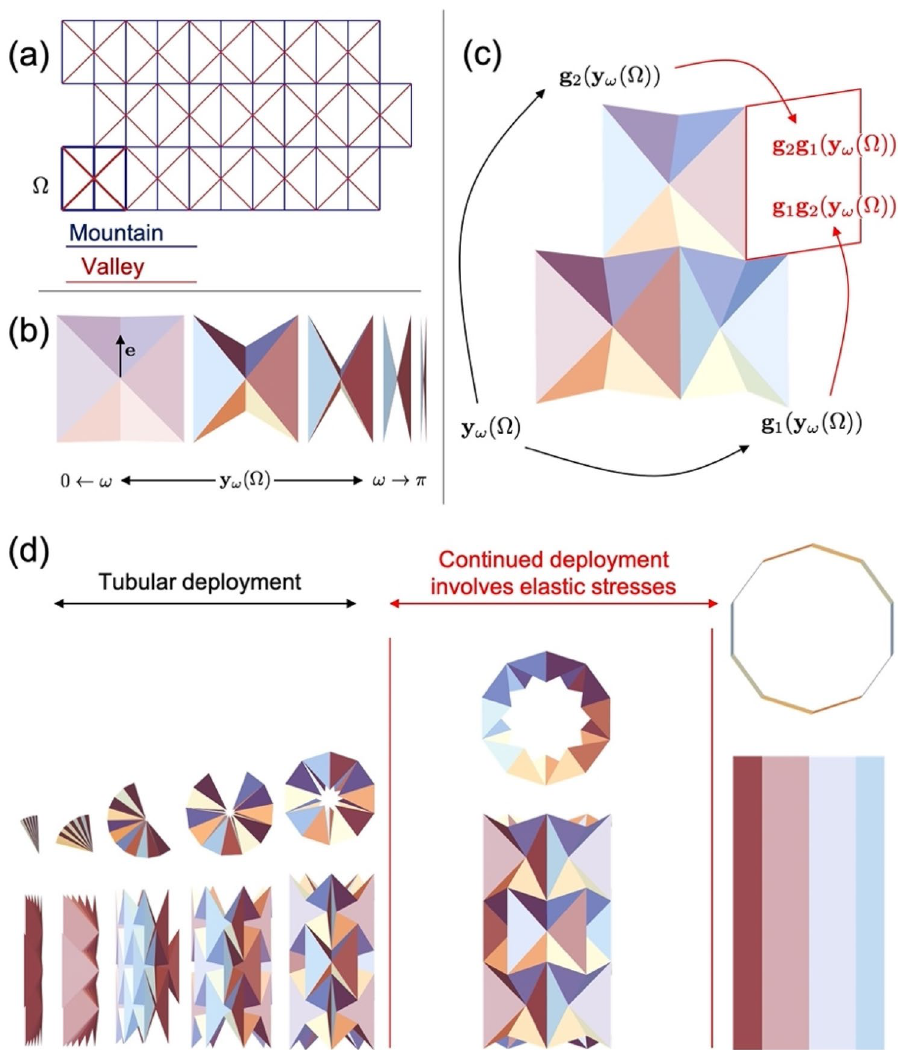
Figure 1. Group theory approach to waterbomb origami. ( a ) The crease pattern, unit cell, and mountain-valley assignment associated with this origami. ( b ) Symmetric kinematics of the unit cell. The axis of symmetry is indicated by e . ( c ) Method to obtain an overall origami structure by application of isometries to the unit cell. ( d ) The origami structures involve unfolding from a compact crimped state into potentially three perfect tubes of expanding radius. After unrolling to the first compact tube, the structure can no longer unfold by an ideal origami motion to achieve the other tubular states. The image is made using Mathematica (V 12, https:// www. wolfr am. com/ mathe